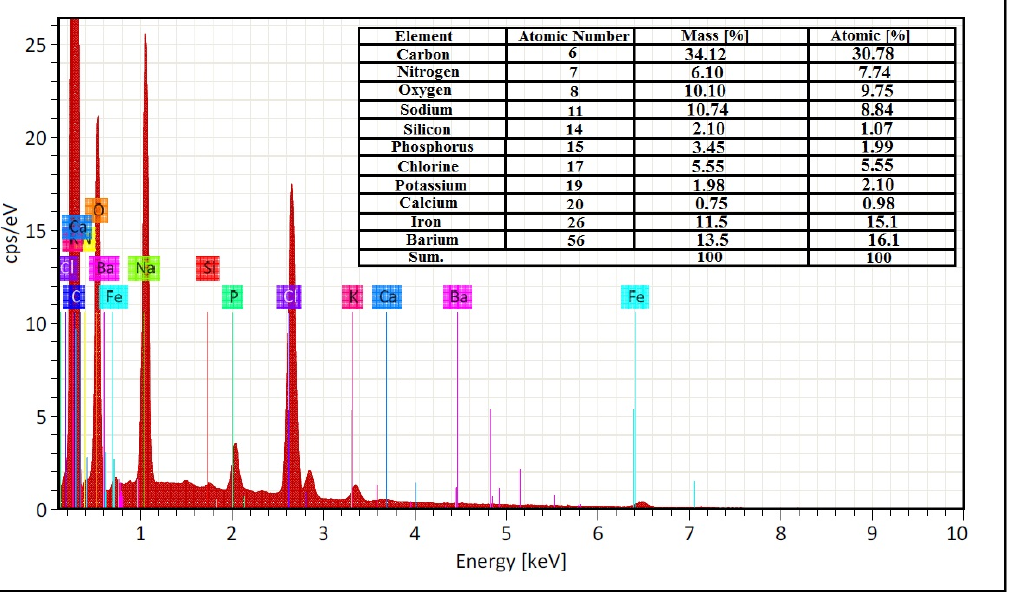
Figure 6. Elemental analysis of the synthesized alpha-amylase doped on chitosan-loaded barium ferrite nanoparticles. The typical X-ray peaks of C, N, O, Na, Si, P, Cl, P, Ca, Fe, and Ba atoms are observable in the EDX of synthesized alpha-amylase-BFCMNPs. The C, N, O, Na, Si, P, Cl, P, and Ca atoms correspond to glutaraldehyde, alpha-amylase, chitosan, and sodium phosphate buffer components.